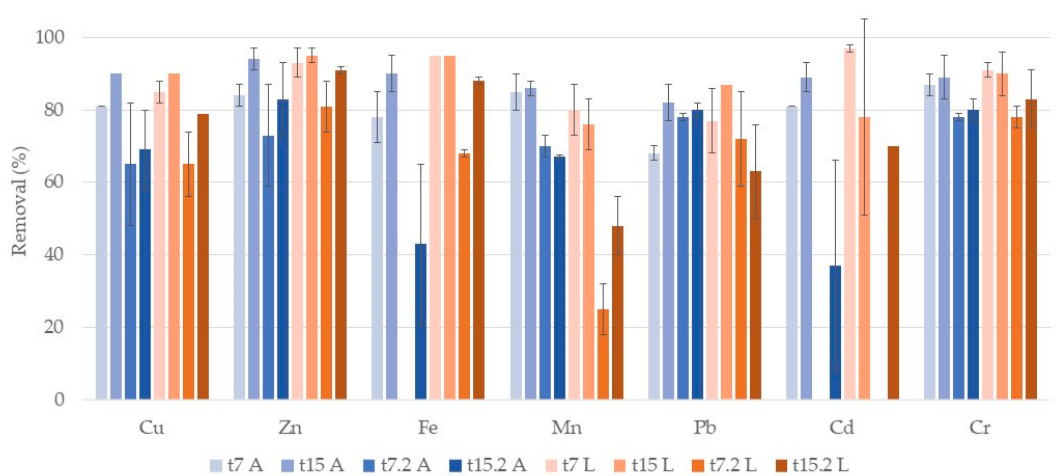
Figure 6. Removal percentage and respective standard deviation ( n = 3) for each metal, in CWs with T. latifolia and expanded clay (t7 A, t15 A, t7.2 A, t15.2 A) and lava rock (t7 L, t15 L, t7.2 L, t15.2 L) over the two cycles of treatment. First cycle: samples taken after one week (t7) and at the end of the two ‐ week cycle (t15). Second cycle: samples taken after one week (t7.2) and at the end of the two ‐ week cycle (t15.2). At t7.2 A there was no removal of Fe and Cd, and at t7.2 L there was no removal of Cd.